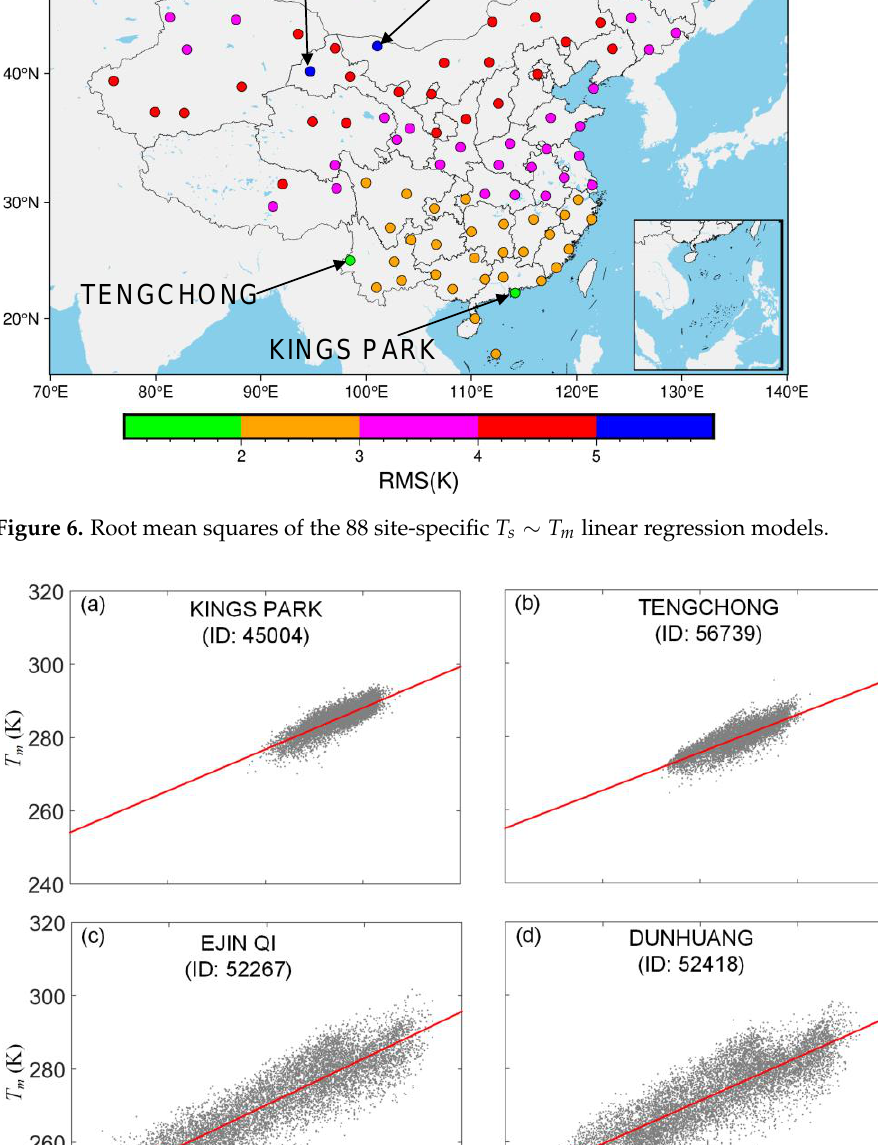
Remote Sens. 2023 , 15 , x FOR PEER REVIEW 10 of 23